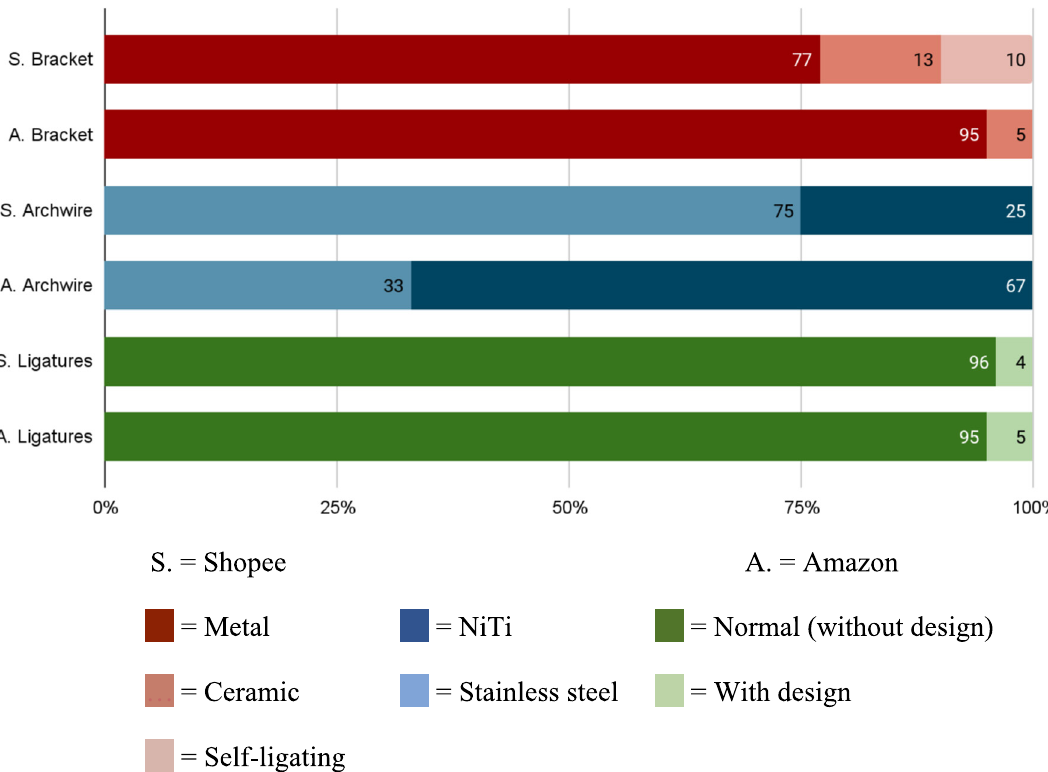
Figure 1. Percentage of types of orthodontic products according to